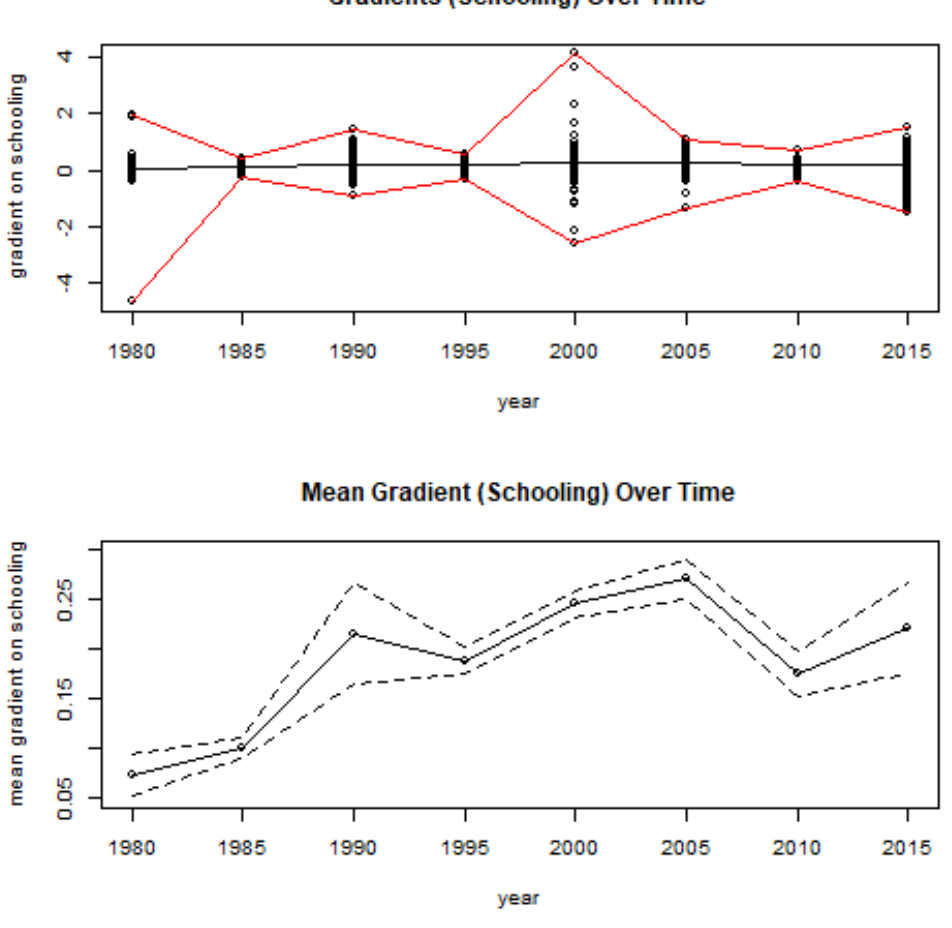
Figure 1. Gradients on schooling (education) from Step